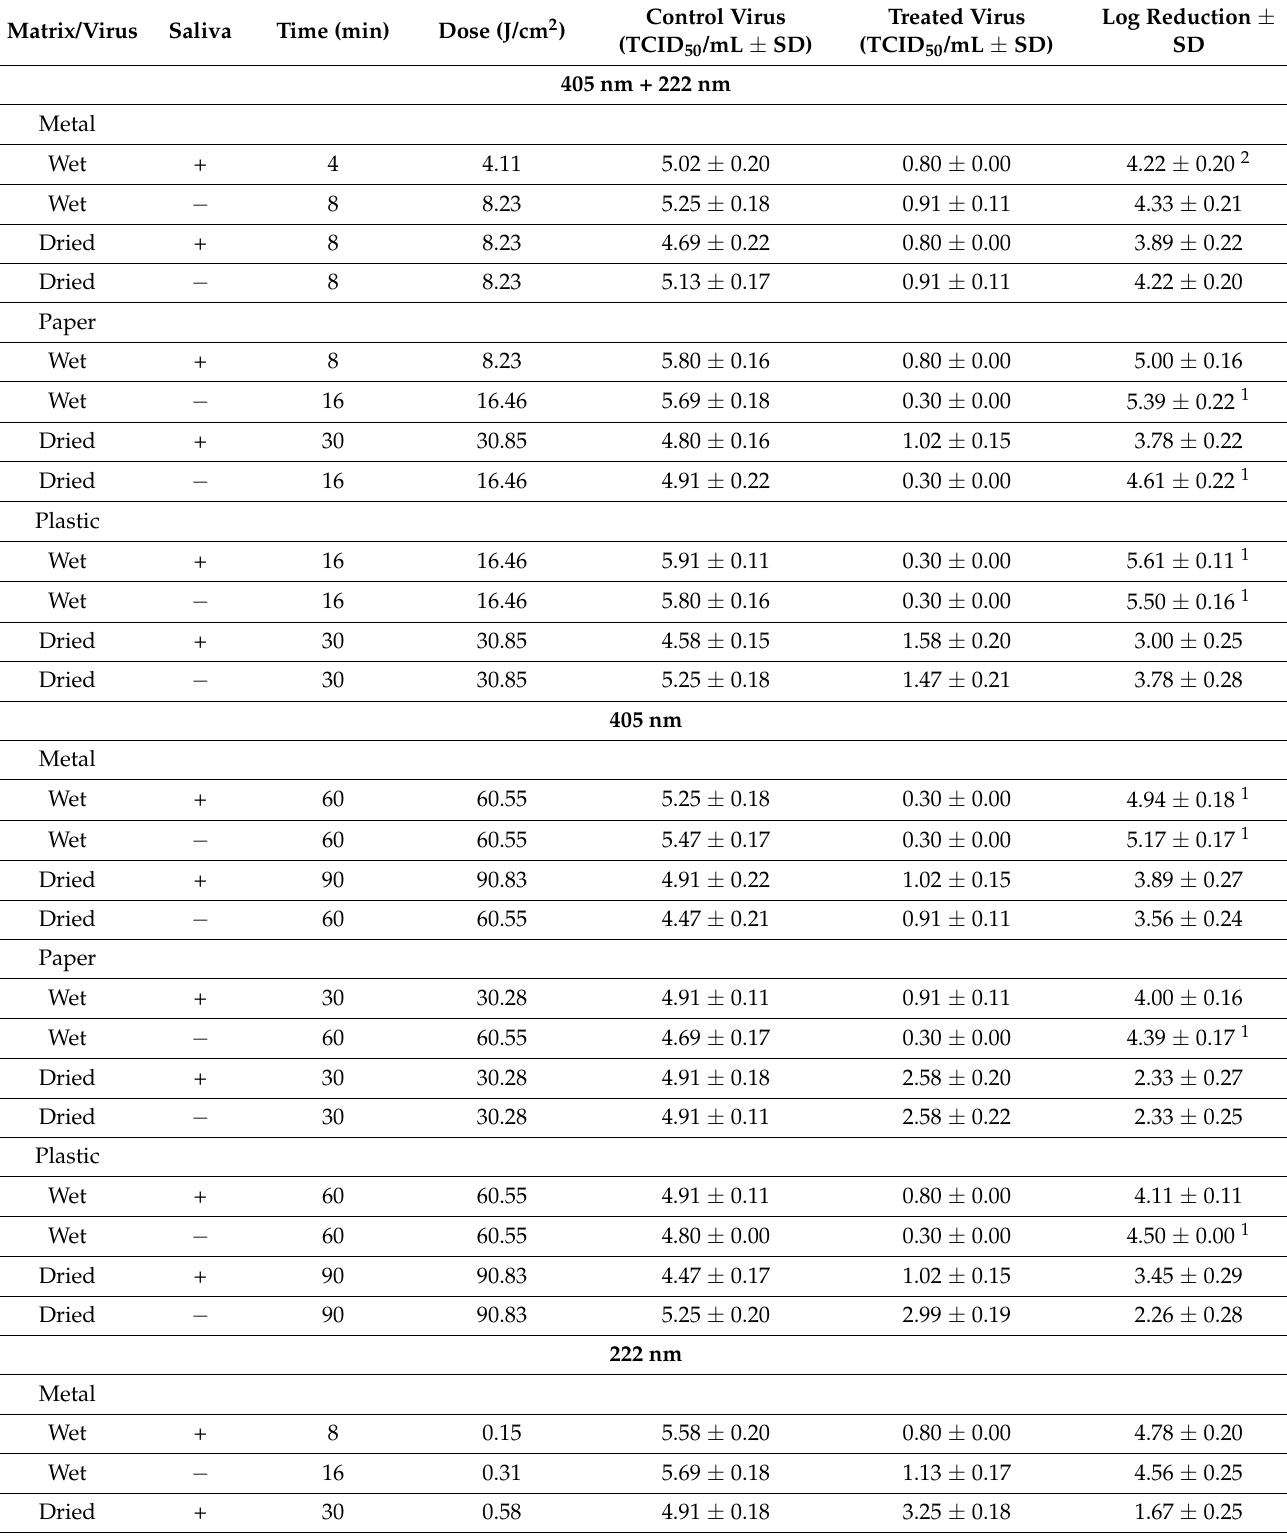
Table 2. Time and dose at which a 4-log reduction in titer was reached for dried or wet feline infectious peritonitis virus (FIPV) on three different surfaces (metal, paper, plastic) in the presence and absence of artificial saliva. All exposures were conducted at 25 cm